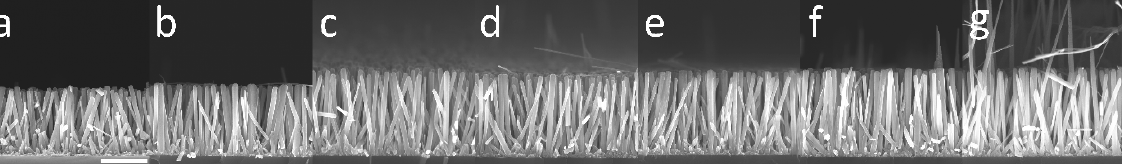
Figure 4. Cross-sectional-view FESEM images of ZnO NWs grown by CBD at 90 ◦ C with 30 mM of Zn(NO 3 ) 2 and HMTA for 41 h with reactor heights of ( a ) 0.5, ( b ) 0.9, ( c ) 1.2, ( d ) 1.9, ( e ) 2.1, ( f ) 2.7, and ( g ) 4.0 cm, respectively. The scale bar represents 1 μ m.